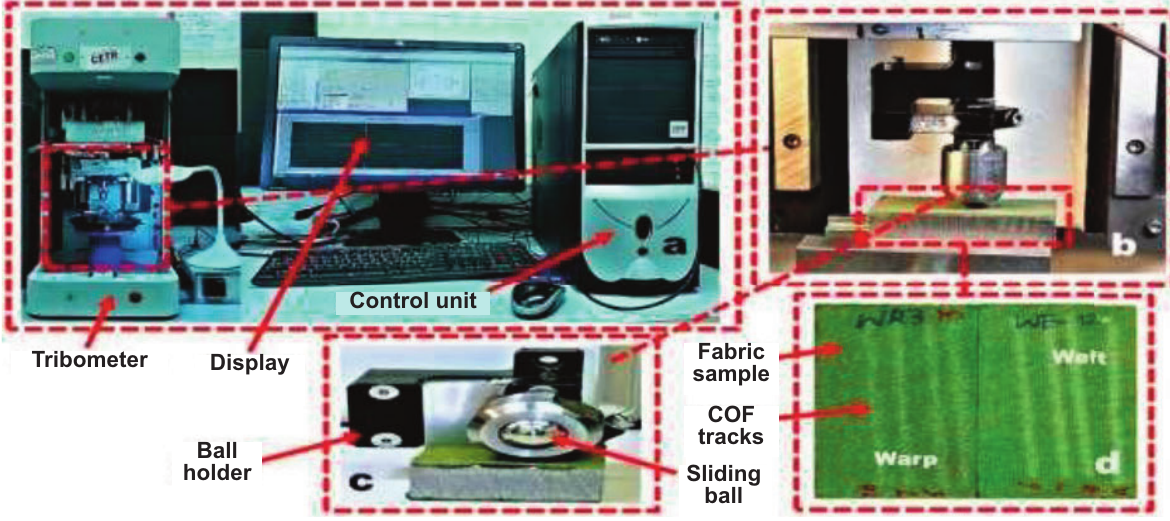
Fig. 1. COF setup: (a) tribometer equipment, (b) experiment demonstration, (c) ball slider and (d) fabric